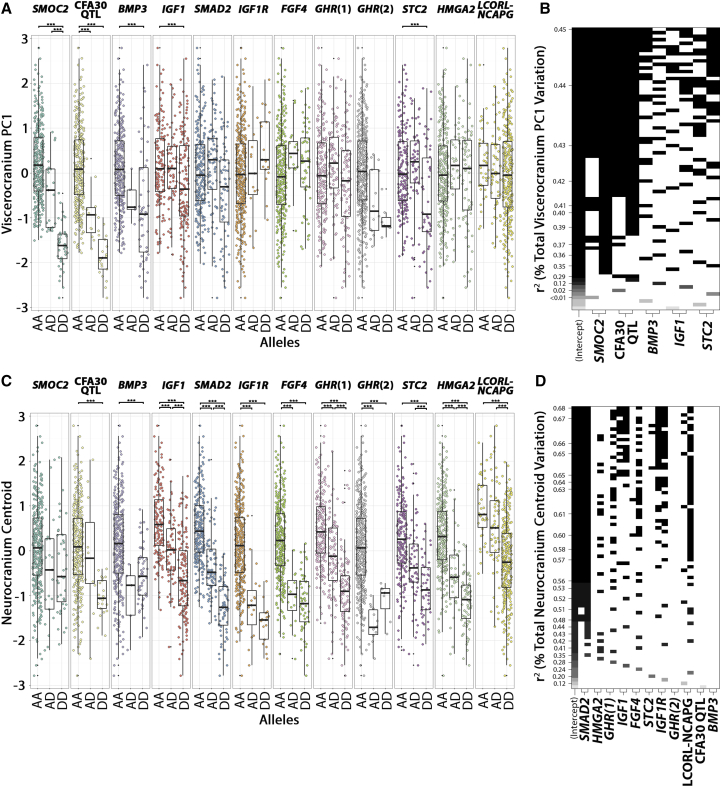
Size Effects of the Viscerocranium Shape and Neurocranium Centroid Size QTL(A and C) Boxplots depicting the distribution of normalized size-corrected viscerocranium PC1 (A) and normalized neurocranium centroid size (C) for 11 loci linked with body size and skull shape. Distributions are subdivided by genotype —homozygous ancestral (AA), heterozygotes (AD), and homozygous derived (DD). ∗∗∗ denotes p < 0.001 in Mann-Whitney-Wilcoxon and Kolmogorov-Smirnov tests.(B and D) A stepwise linear regression model for viscerocranium PC1 (B) and neurocranium centroid (D) determined the best explanatory model for ancestral (left) and derived (right) genotypes for each positional candidate.